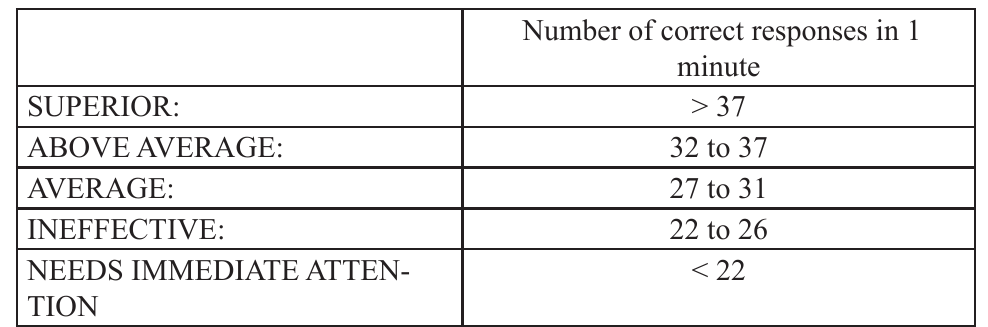
Table 11: The norms obtained for Visual Response Time with the use of the Wayne Saccadic Fixator